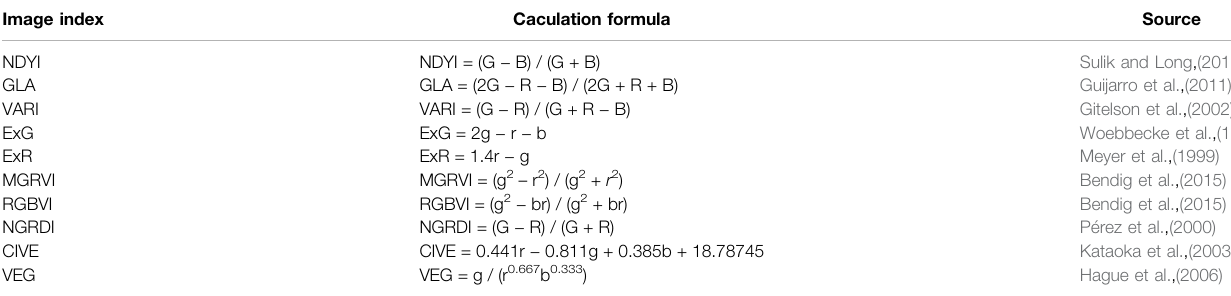
TABLE 1 | RGB vegetation indices.